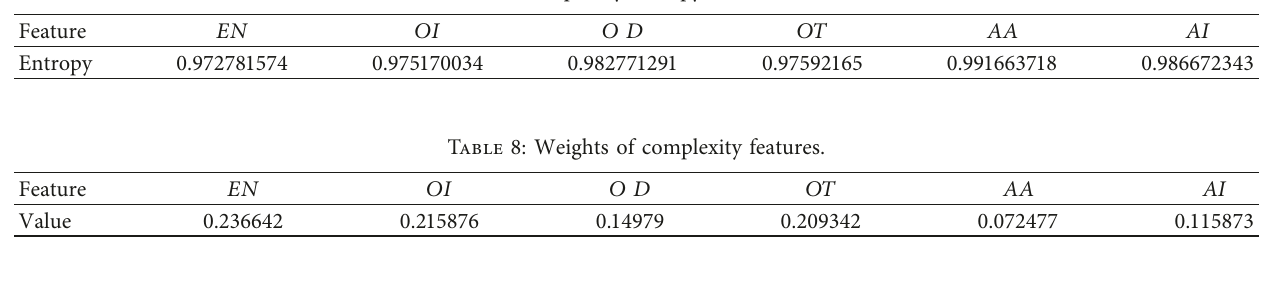
Table 7: Complexity entropy of all features.